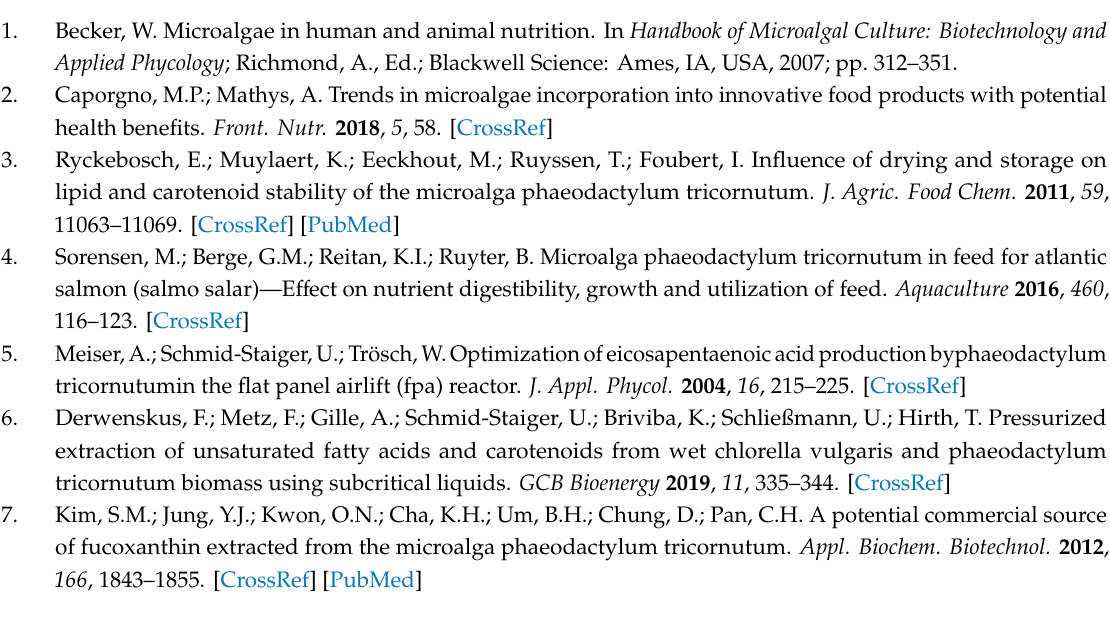
Figure S1: E ff ects of PTE supplementation to C57BL / 6J mice fed with a high fat diet on liver histological appearance and lipid content, Figure S2: E ff ects of PTE supplementation to C57BL / 6J mice fed with a high fat diet on the appearance of crown-like structures in inguinal white adipose